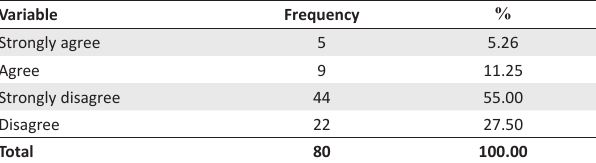
TABLE 6: Managers are comfortable with the current practice of three performance review meetings per year.